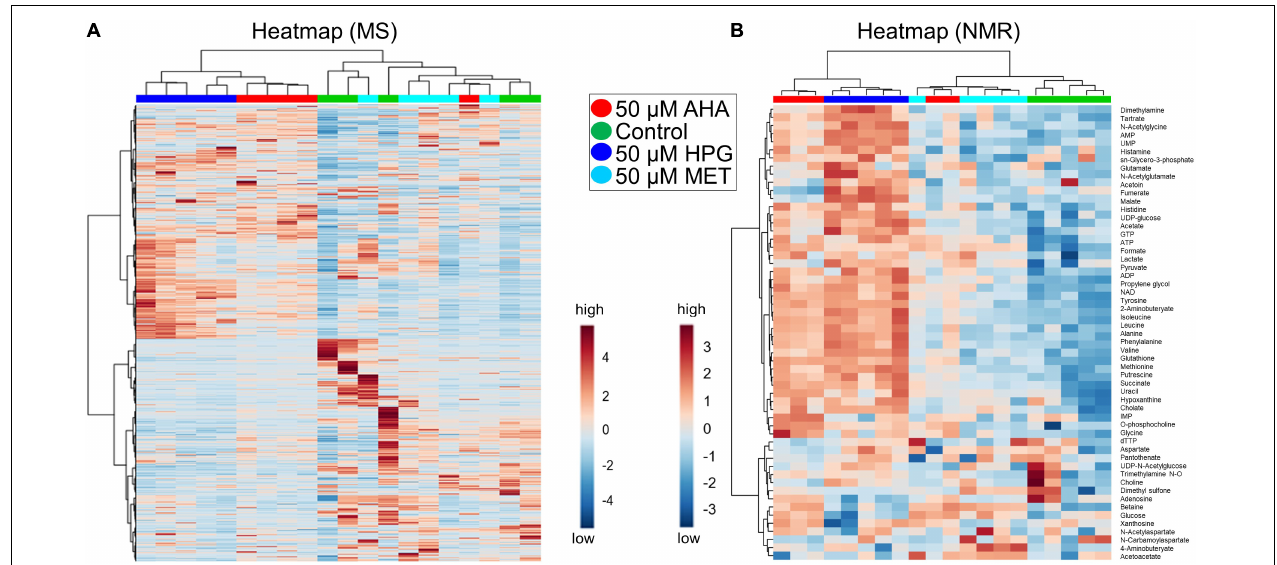
FIGURE 4 | Heatmaps of heat stressed E. coli cultures. Data from MS and NMR are shown ( A,B , respectively). Heat map is coded with blue as low and red as high abundance. Fold change is indicated on the scale. (A) AHA and HPG doped stressed E. coli cultures show segregated clustering in the MS heatmap of all features (5,960 detected features). (B) The NMR heatmap (55 identified features) shows distinct clustering of Control, HPG, and Met, the exception being AHA which had moderate clustering with MET. For enlarged images that show metabolite names and sample identifications see Supplementary Figure S5